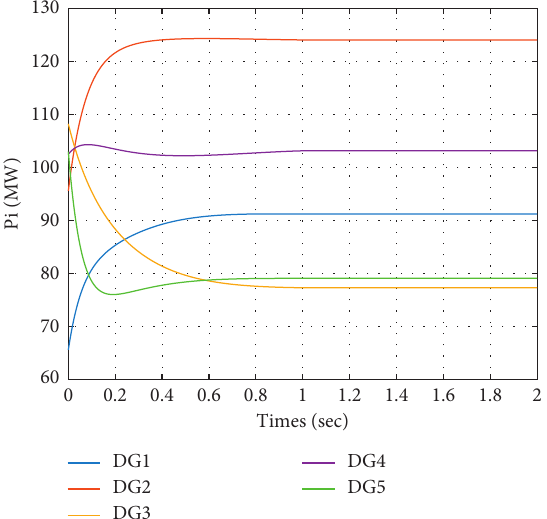
Figure 13: The output power of generator P